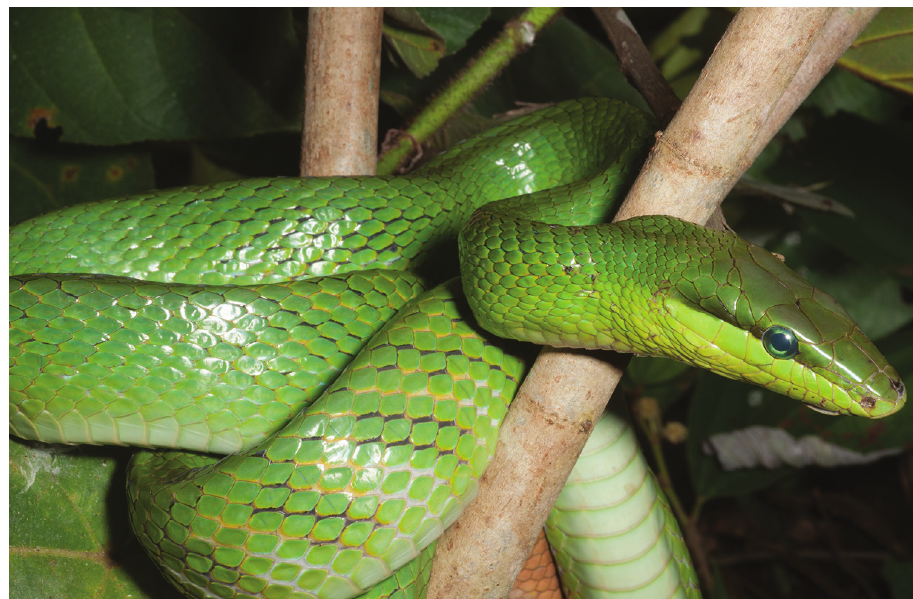
Figure 67. Gonyosoma oxycephalum has been collected on Dinagat Island and in Agusan del Sur; this specimen was photographed at the Municipality of Burauen, Leyte Island (specimen deposited in KU). Photo: RMB.